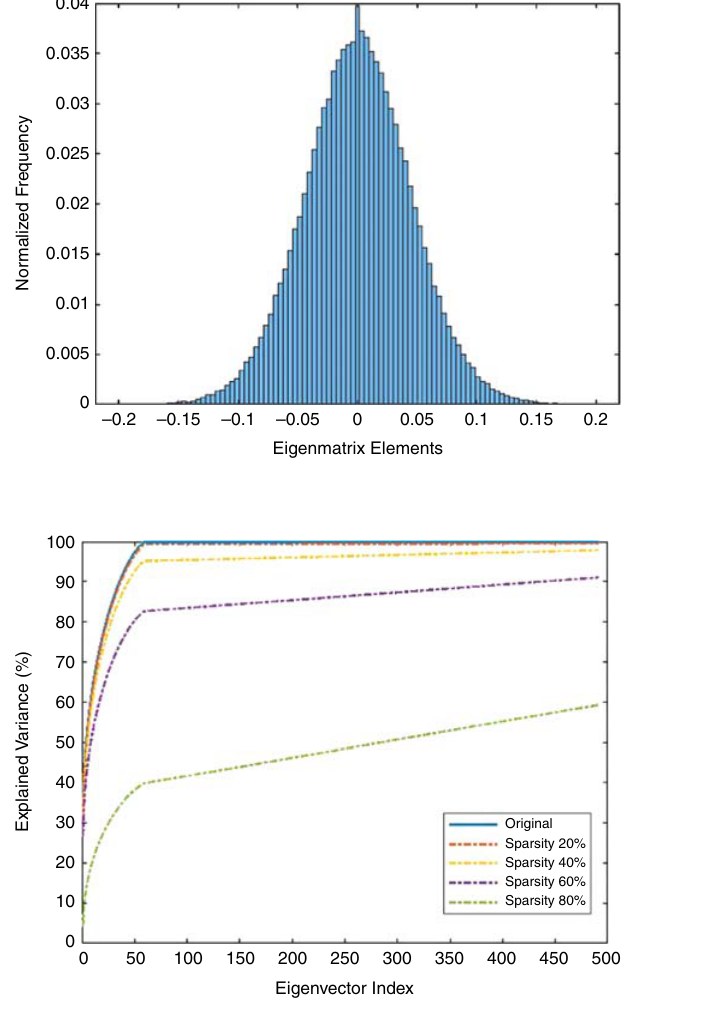
Figure 2. Cumulative explained variances as a function of the number of eigenvectors included in representation for different levels of sparsity